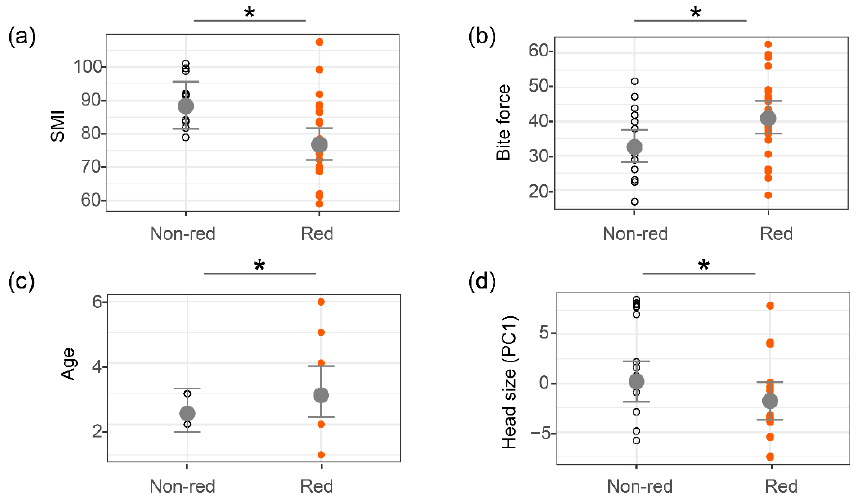
Figure 5. Relationship between ( a ) throat colour variants (non-red, red) and scaled mass index (SMI) of females; ( b ) throat colour variants and bite force in females; ( c ) throat colour variants and age in males; ( d ) ventral colour variants and head size in females. Orange points show the trait value of red variant, and black points show the trait value of non-red variant. Grey points are the predicted average value, and error bars represent the 95% confidence interval. “*” indicates significant association. See Table 2 for nonsignificant relationships.